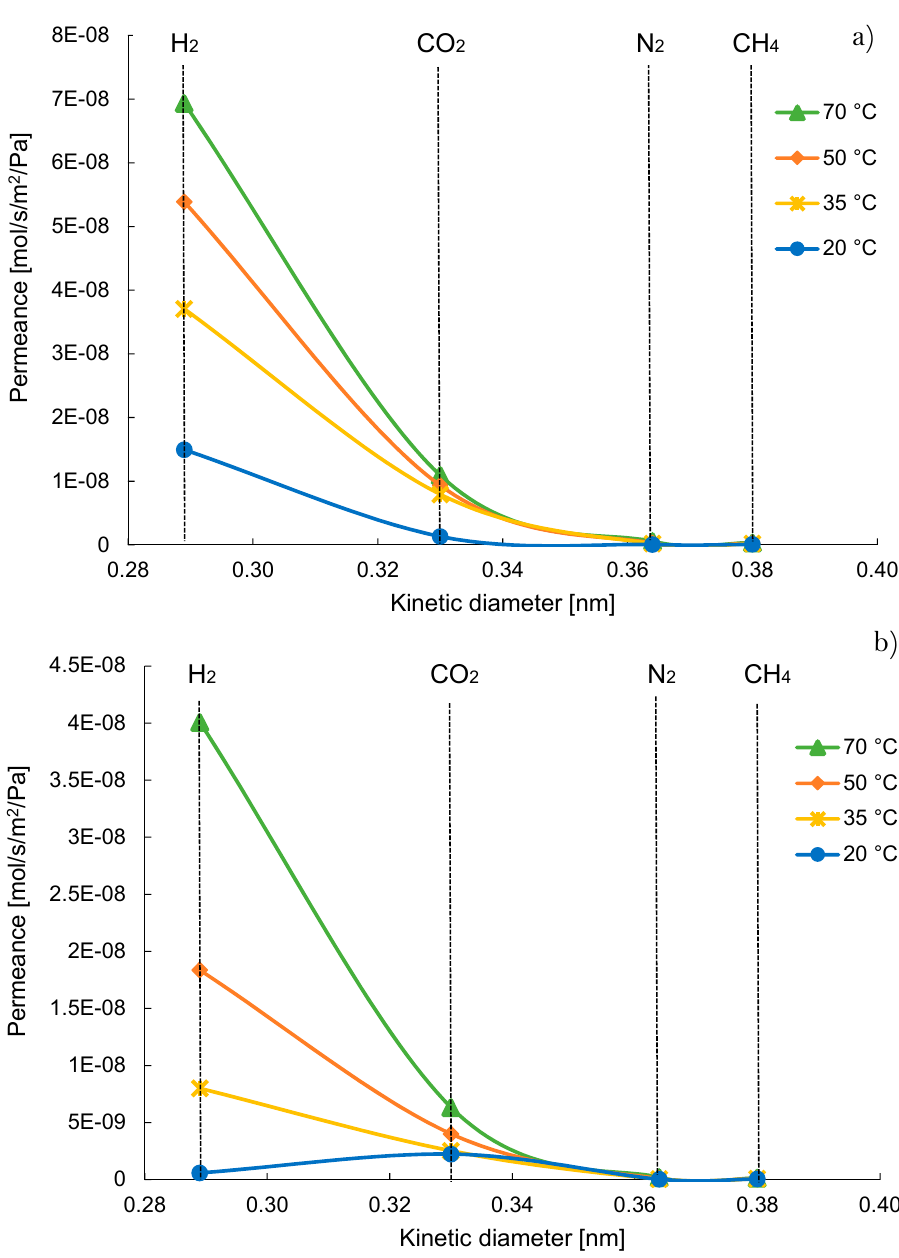
Figure 5. Permeance as a function of the kinetic diameter of gases at various temperatures and 30 bar of pressure difference ( a ) with dry gas; ( b ) with humidified gas of membrane CMSM 550.